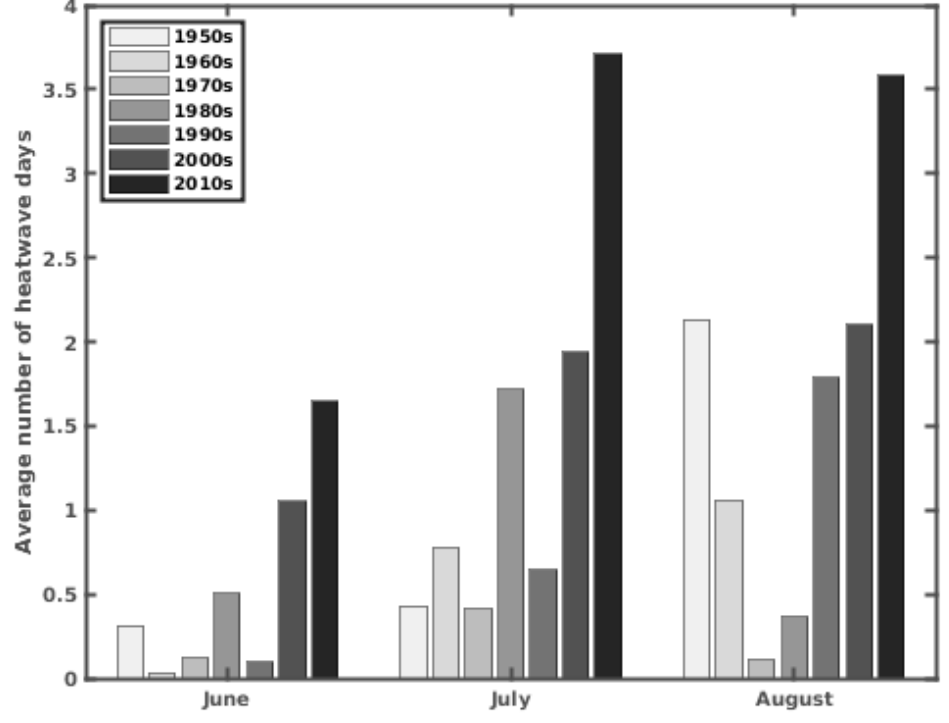
Figure 11. Average numbers of summer heatwave days per decade for Greece calculated from ERA5-Land during the period 1950–2020.